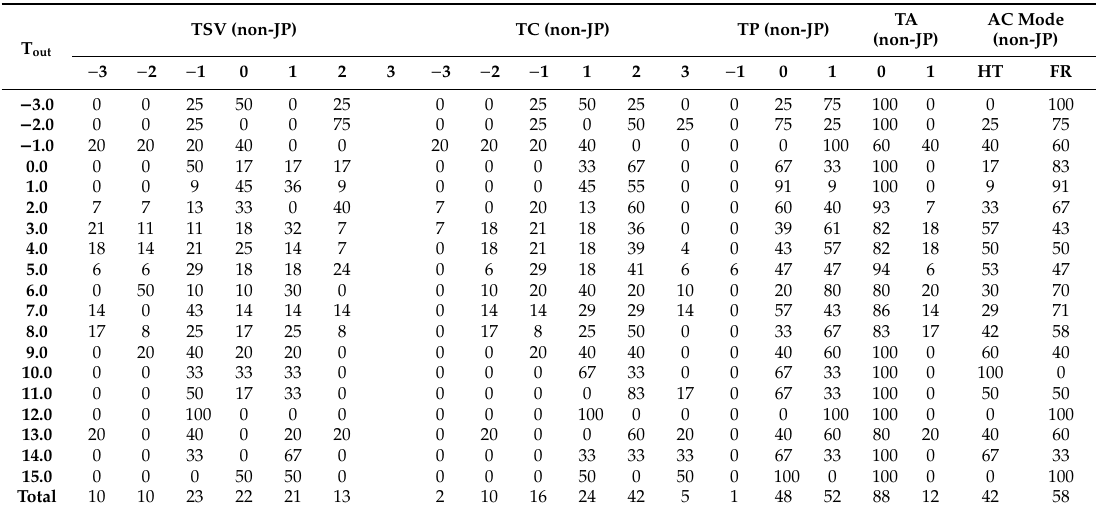
Table A5. Descriptive statistic: Thermal responses in relation to climate. Frequency distribution non-Japanese winter data points (%) N =